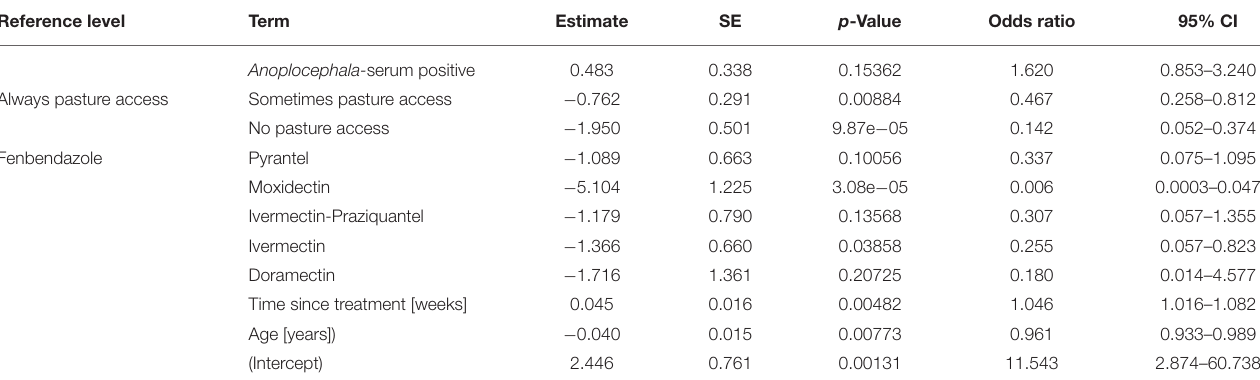
TABLE 5 | Final logistic regression model to identify risk factors explaining positivity for strongyle type eggs. Reference level